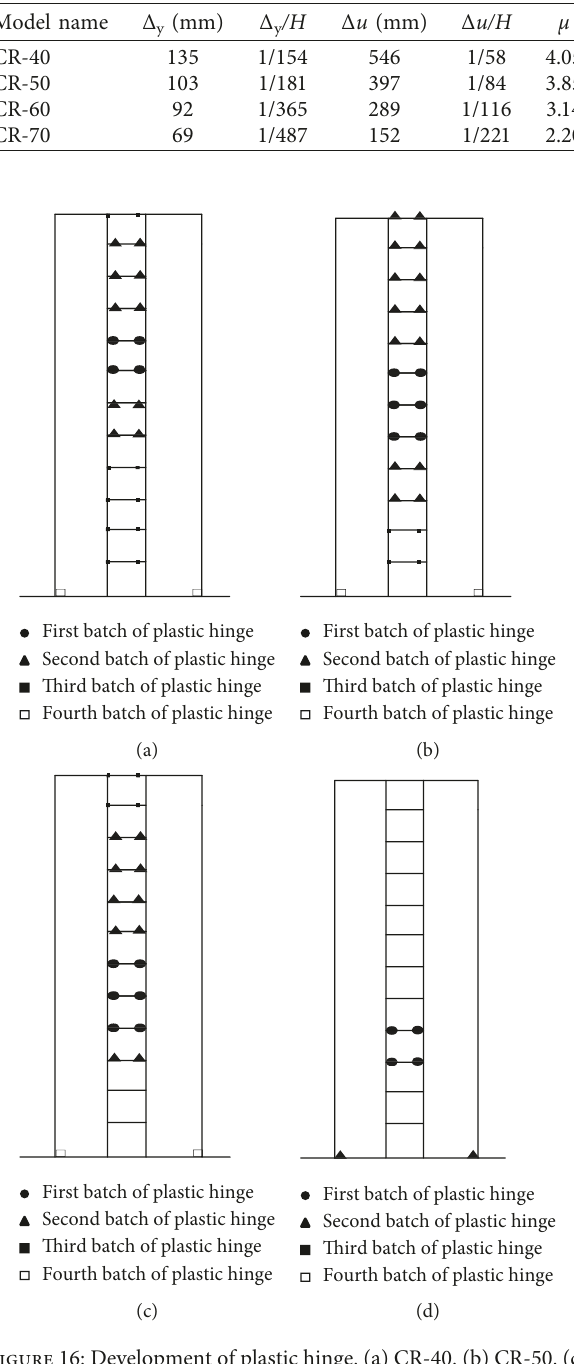
Figure 16: Development of plastic hinge. (a) CR-40. (b) CR-50. (c) CR-60. (d) CR-70.